Question: Briefly state, in one sentence, what is plotted here.
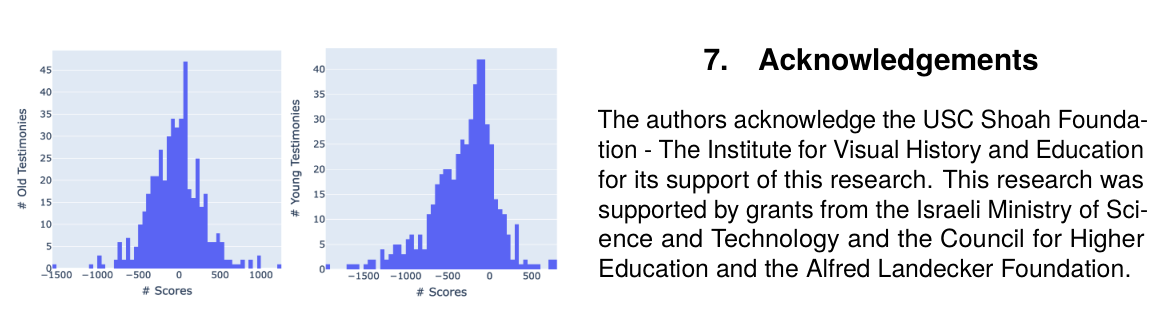
Answer: Testimonies scores histogram.